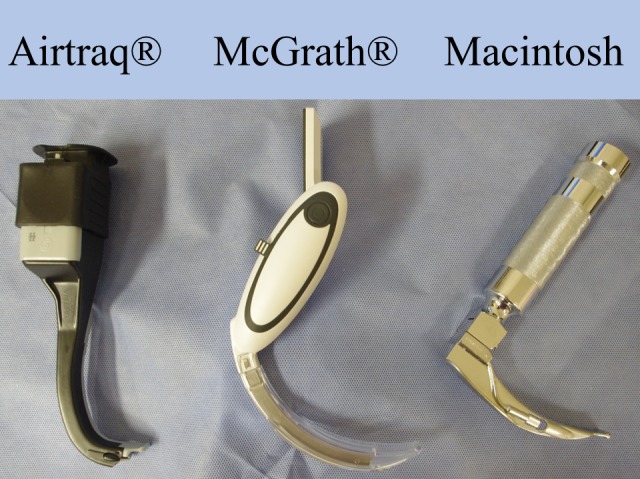
A photo of the Airtraq®, McGrath®, and Macintosh laryngoscopes used in the study.